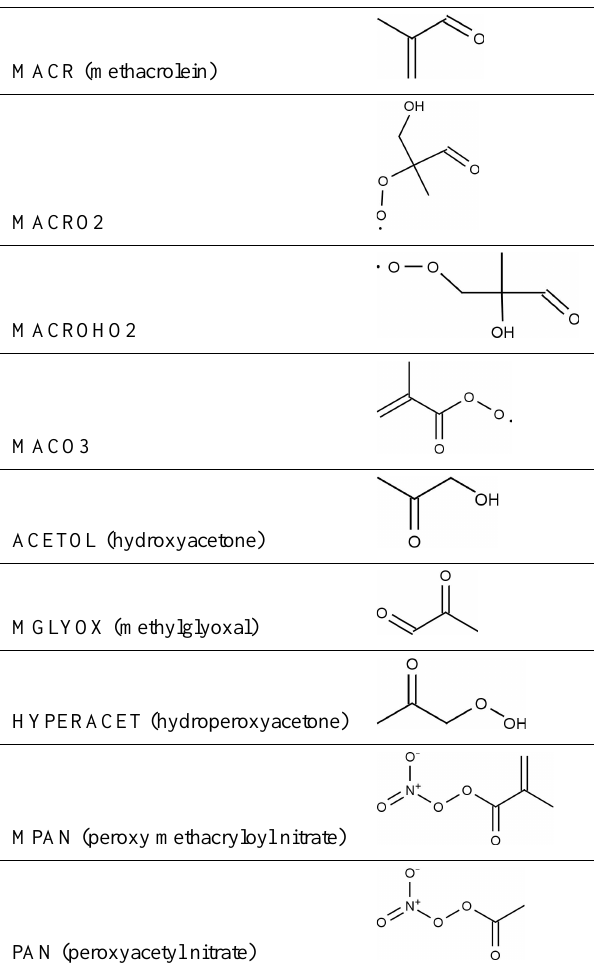
Table 3. Chemical structure of MACR and products from its oxida- tion with OH. Acronyms are taken from the